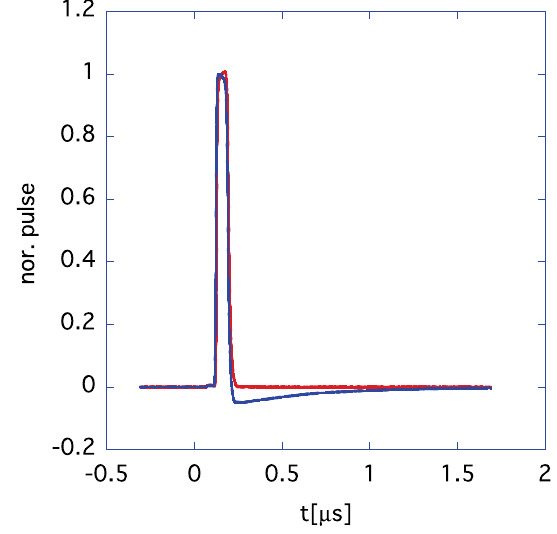
FIG. 18. Comparison between the right-hand side of Eq. (51) (red/blue) and the right-hand side F =Z 50 (purple/green) of Eq. (48) for the ceramic break in the lower figures of Fig. 4, where R ¼ 0 . 75 Ω , L ¼ 0 . 432 μ H, and C ¼ 0 . 46 nF. The solid and dashed lines show their real and imaginary parts.